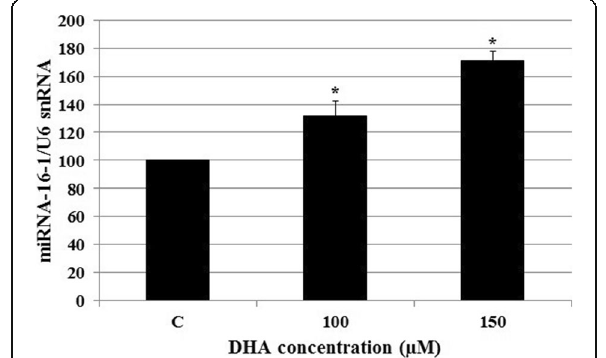
Fig. 4 Effect of DHA on the p53 protein level. 5×10 5 HCT-116 cells per well were treated with different concentrations of DHA for 48 h, after which Wt-p53 protein levels in tumor cell lysates were measured by ELISA. All experiments were repeated twice using triplicate assays, and the results were presented as mean±SD. * P <0.05 and ** p <0.01 vs. untreated control cells (C)